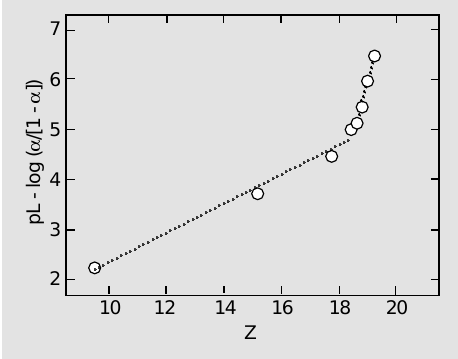
4. Dependence of the saturation of binding sites on trypsin by flavianate after 18-h incubation upon the net charge on the enzyme (Equation 2). The dotted lines represent linear ad- justments applied to each data set. The a parameter represents the fraction of bound sites n /n in